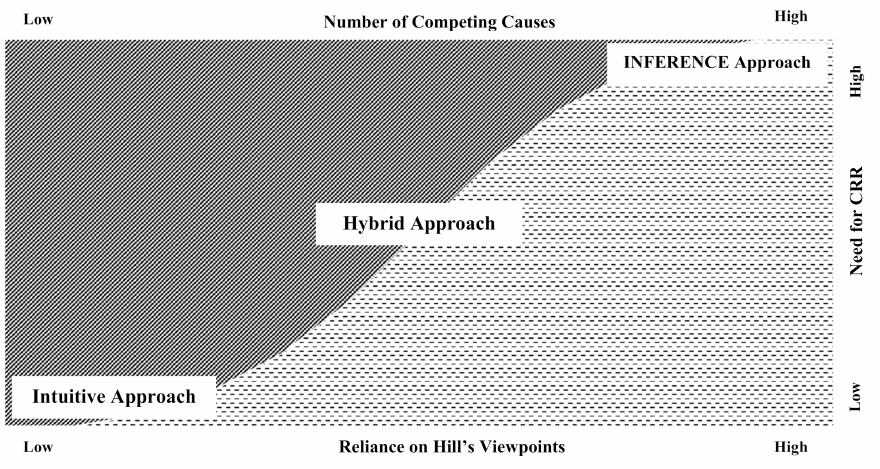
Figure 1. Which causal analysis approach is the most suitable for the specific